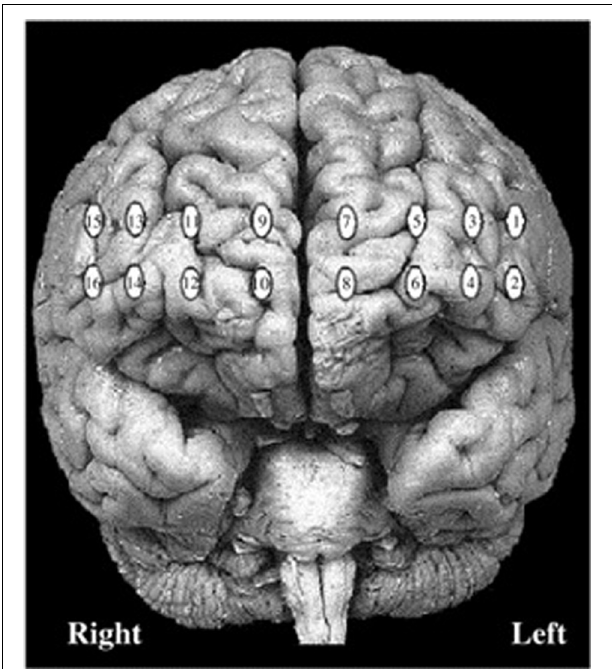
FIGURE 2 | Locations of 16 channels for continuous-wave functional near-infrared spectroscopy system.